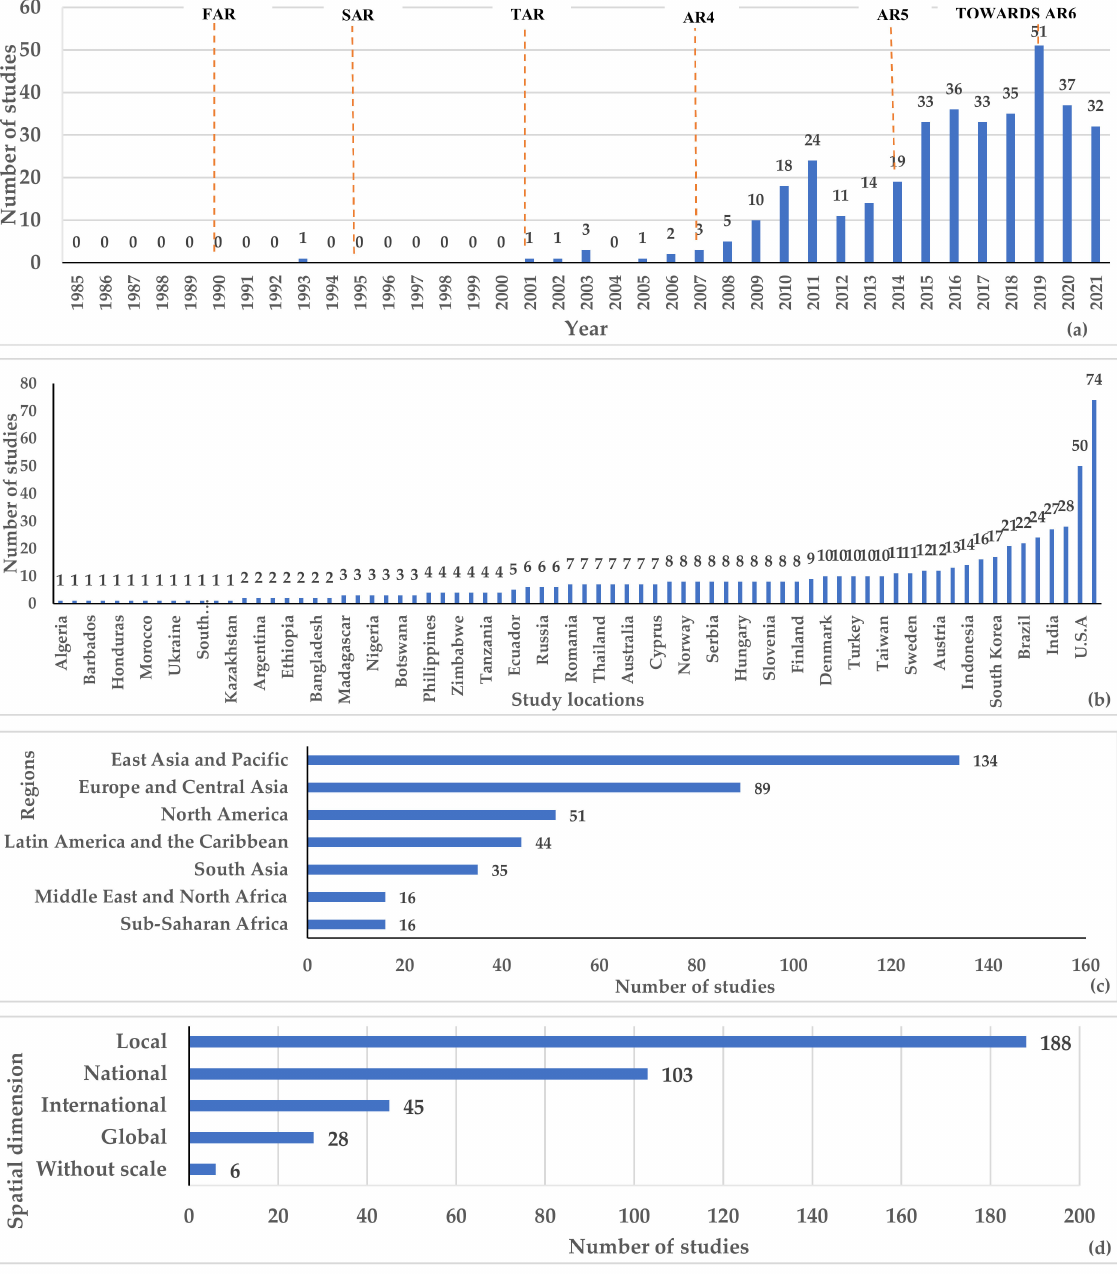
Figure 2. Study characteristics based on number of publications by year ( a ), study locations ( b ), regional distribution ( c ), and spatial dimension ( d ) of the literature used in the